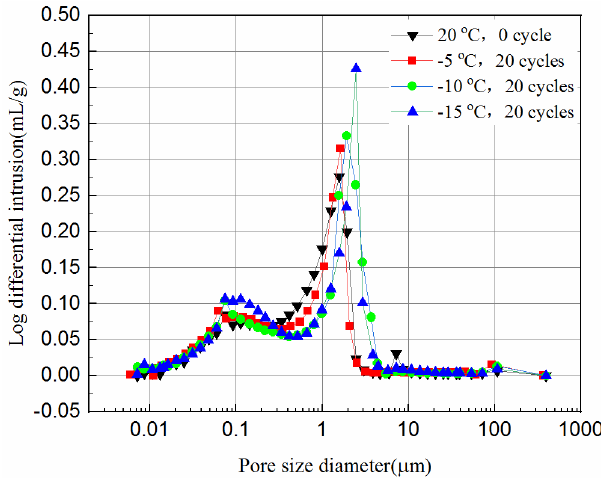
Figure 12. Log-differential pore volume curves of 7-day samples at different cooling temperature.